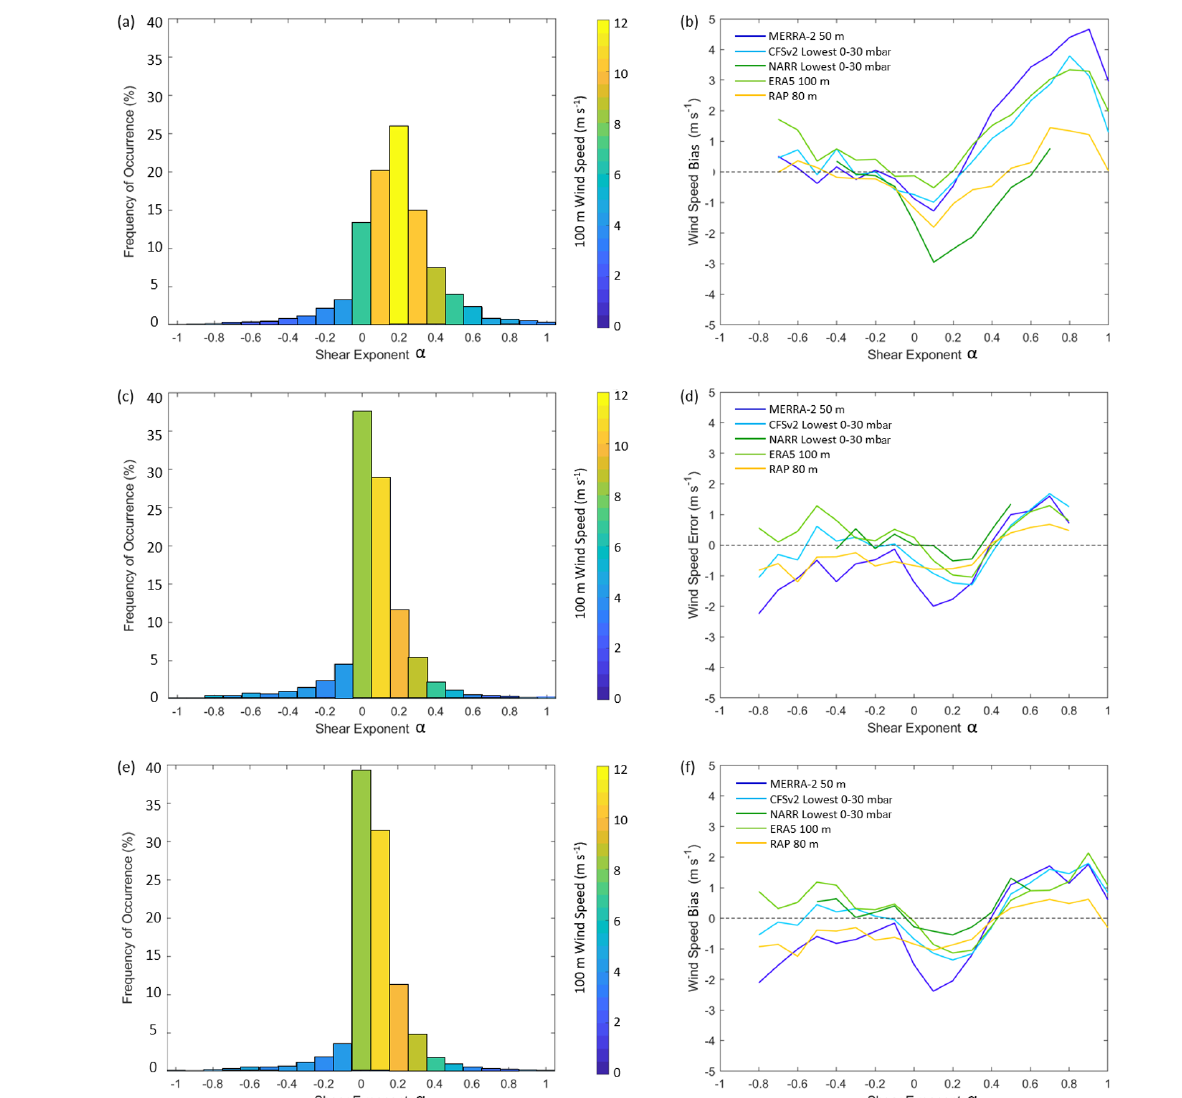
Figure 9. Distribution of shear exponent α at (a) Humboldt, (c) Morro Bay during the overlapping Humboldt period, and (e) Morro Bay during the full seasonal cycle, colored by observed 100m wind speed. Average hub height wind speed bias according to α at (b) Humboldt, (d) Morro Bay during the overlapping Humboldt period, and (d) Morro Bay during the full seasonal cycle.